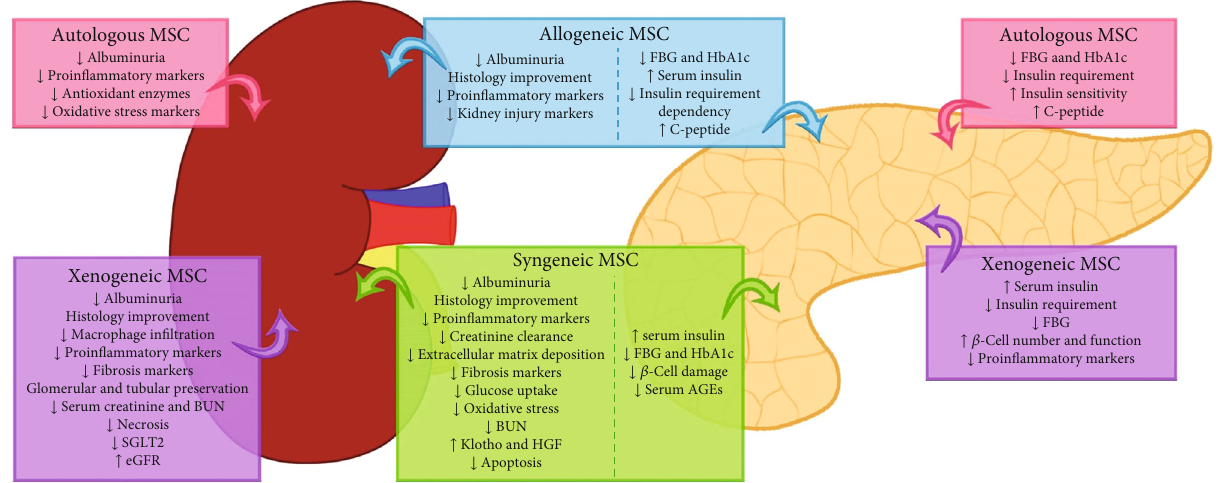
Figure 1: Main fi ndings of preclinical and clinical studies evaluating MSC e ffi